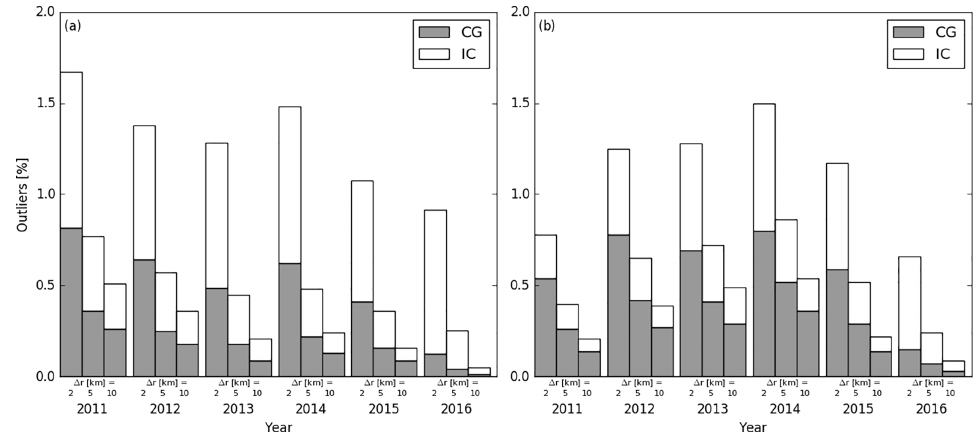
Figure 4. Annual variation of outliers in (a) Belgium and (b) Austria, based on cloud-to-ground (CG) and intracloud (IC) events, for search radii of 2, 5 and